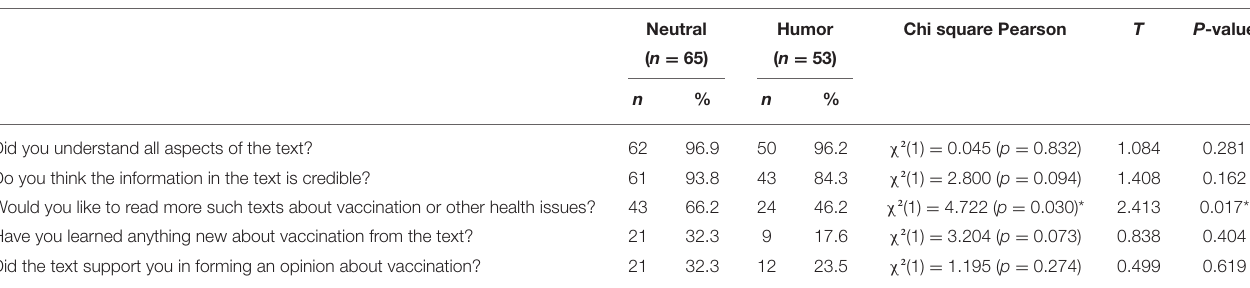
TABLE 2 | Appraisal of the texts ( n =